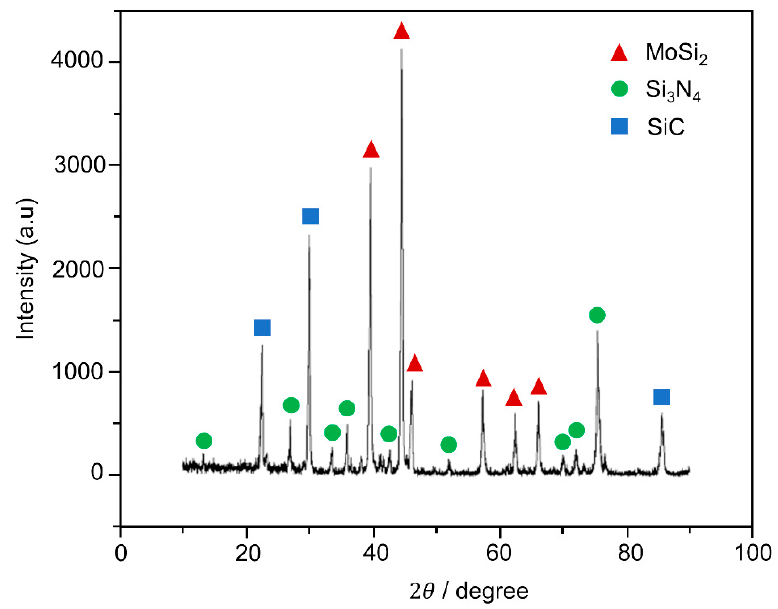
Figure 2. XRD pattern of MoSi 2 -Si 3 N 4 /SiC coated carbon/carbon specimen before the oxidation test.